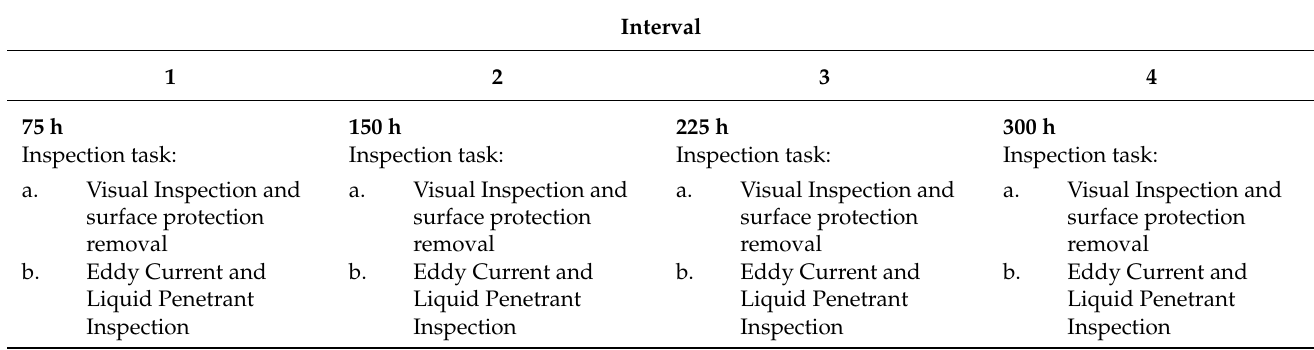
Table 5. New proposed maintenance